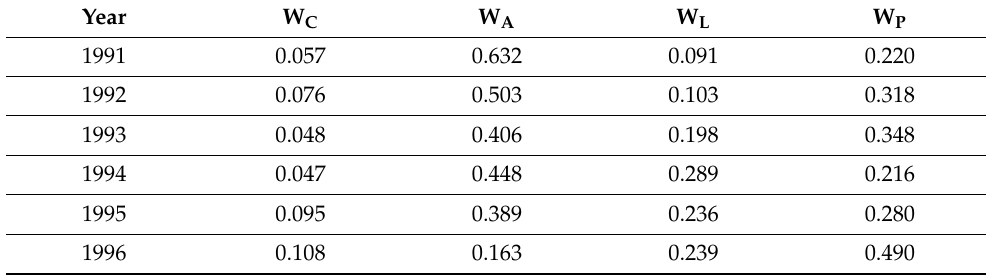
Table 6. Full model weights by year.